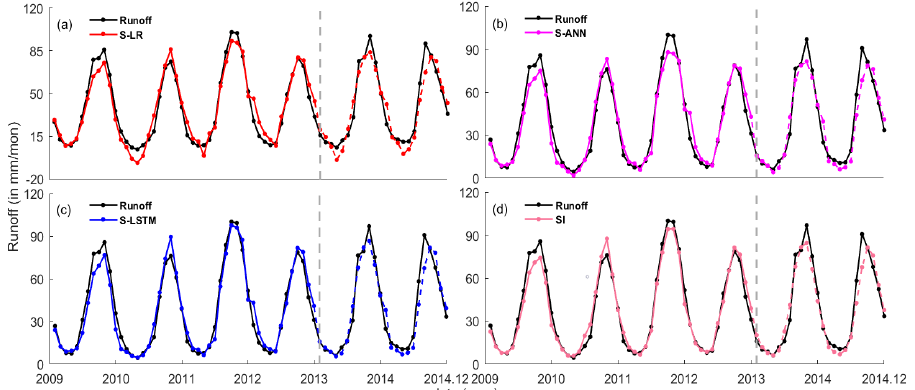
Figure 8. Reconstructed (solid line) and predicted (dash line) runoff at the TC–CD station pair based on remotely sensed water storage ( S ) averaged over the whole upstream area from the Tibetan Plateau to the southern boundary of Cambodia via ( a ) linear regression (LR), ( b ) ANN, ( c ) LSTM, and ( d ) data standardization.